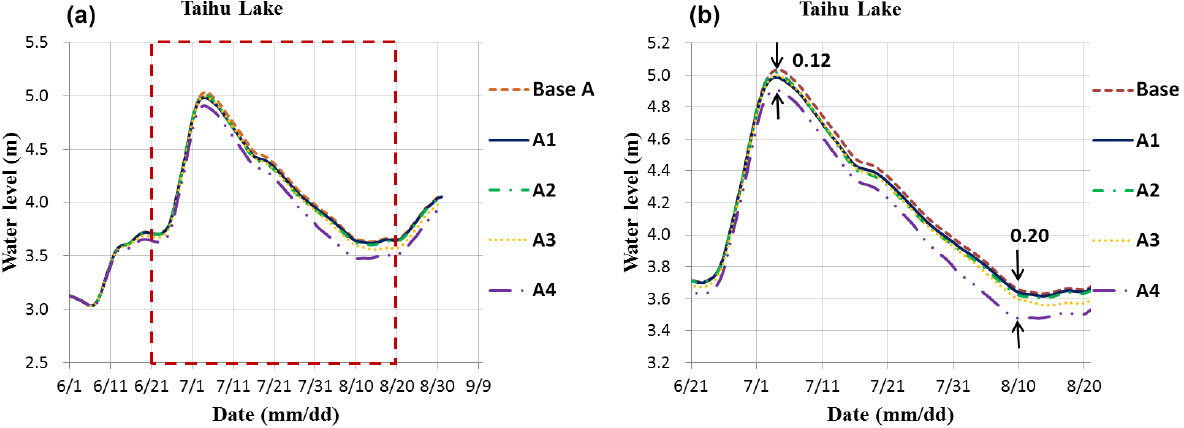
Figure 8. A comparison of the simulated daily lake levels during the period from June to August in 1999 in Lake Taihu under the five scenarios considered in this study (the figure on the right-hand side, b , is the zoom-in plot of the figure on the left-hand side, a